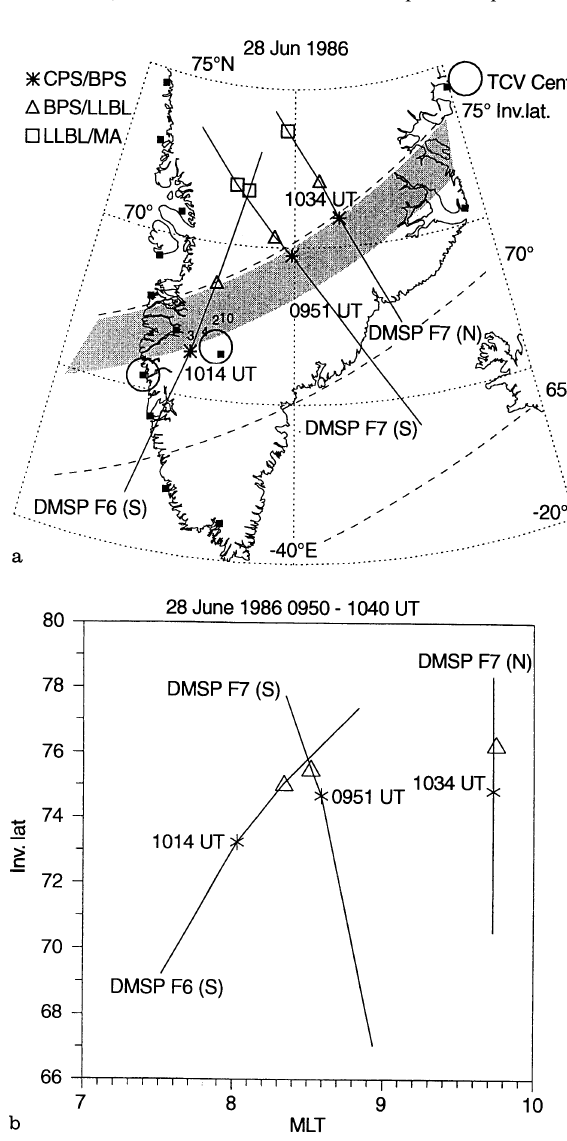
Fig. 1. a Geographic map of the magnetic stations ( small filled squares ) and the locations of the TCV centres for the event of Friis-Christensen et al . (1988). In addition, the DMSP satellite tra- jectories are displayed and on these the detected precipitation boundaries are marked according to the legend in the figure. For further details see the text. b The satellite trajectories of a , including the locations of the precipitation boundaries, are displayed in the Inv. Lat.-MLT coordinate